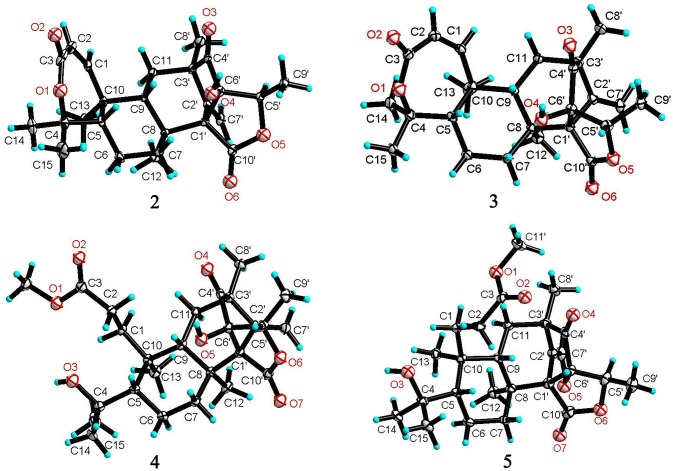
X-ray crystallographic structures of 2-5.